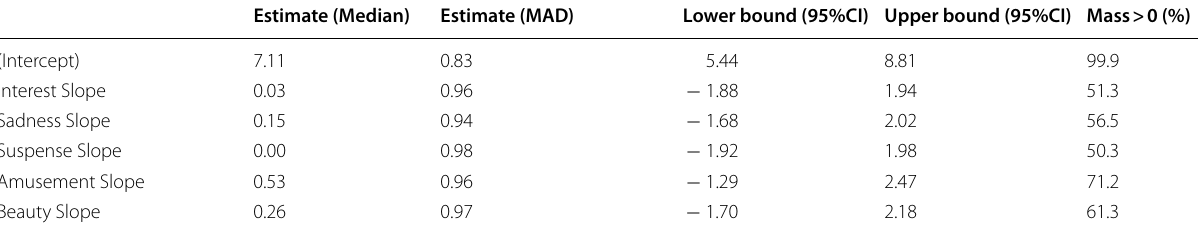
The median, median absolute difference, 95%CI and mass > 0 of the posterior distribution are multilevel models that predicted average scores for story